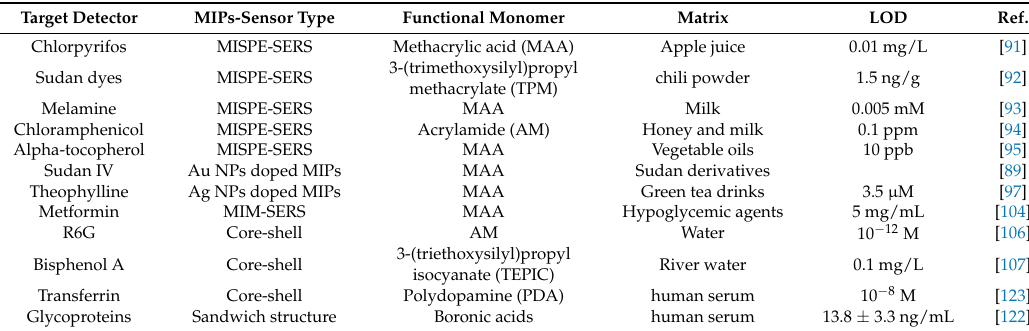
Figure 11. Schematic representation of the boronate-affinity sandwich assay of glycoproteins [122]. Target glycoprotein can be captured specifically by a boronate-affinity MIP array. The captured glycoprotein is then labeled with boronate functionalized AgNPs for SERS detection. Table 3. Representative studies of MIPs-SERS